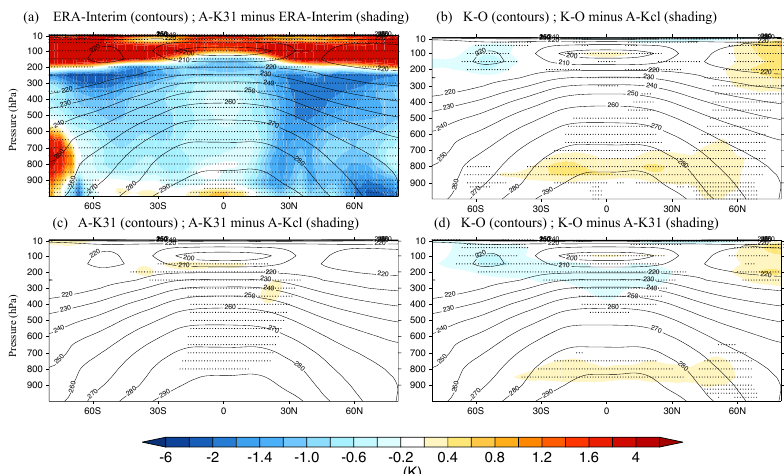
Figure 3. (a) Annual-mean zonal-mean temperature from the ERA-Interim (contours) and bias of A-K31 compared with the ERA-Interim (shading). Impact of interannual SST variability ( c ; A-K31 minus A-Kcl), coupling ( d ; K-O minus A-K31) and both SST variability and coupling ( b ; K-O minus A-Kcl) on the vertical structure of zonal-mean temperature. Stippling indicates where differences are significant at the 95% level. Zonal-mean u ERA-Interim (contours) and [A-K31 - ERA-Interim] (shading)